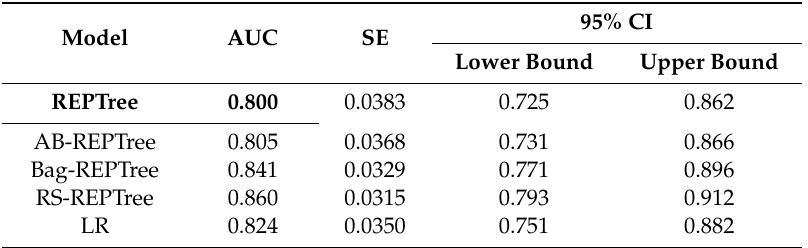
Table 8. ROC curve using the validation